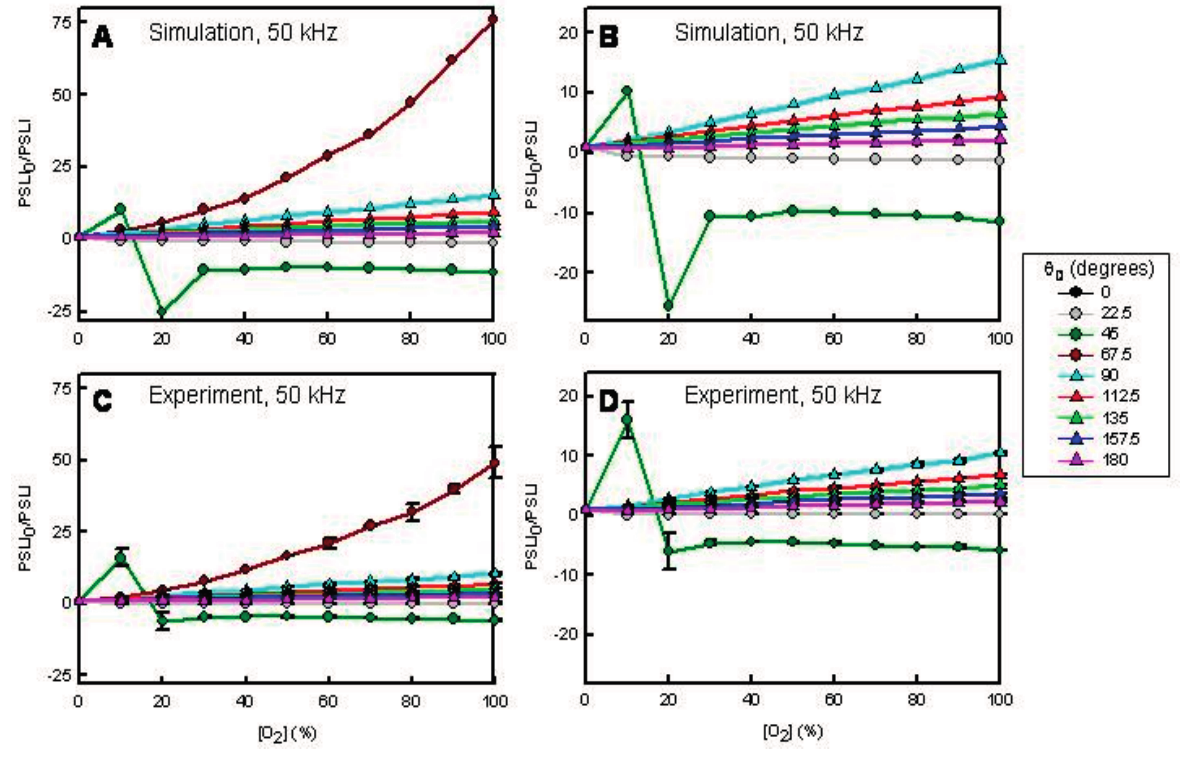
Figure 5. Simulated ( A , B ) and experimental ( C , D ) O 2 -dependent, phase sensitive Stern-Volmer plots for a [Ru(dpp) 3 ] 2+ -doped C8-TEOS/TEOS-based xerogel film at f = 50 kHz. In the simulations τ 0 = 5.0 μ s and K SV = 0.1 O 2 % − 1 . ( B , D ) θ D = 67.5° data